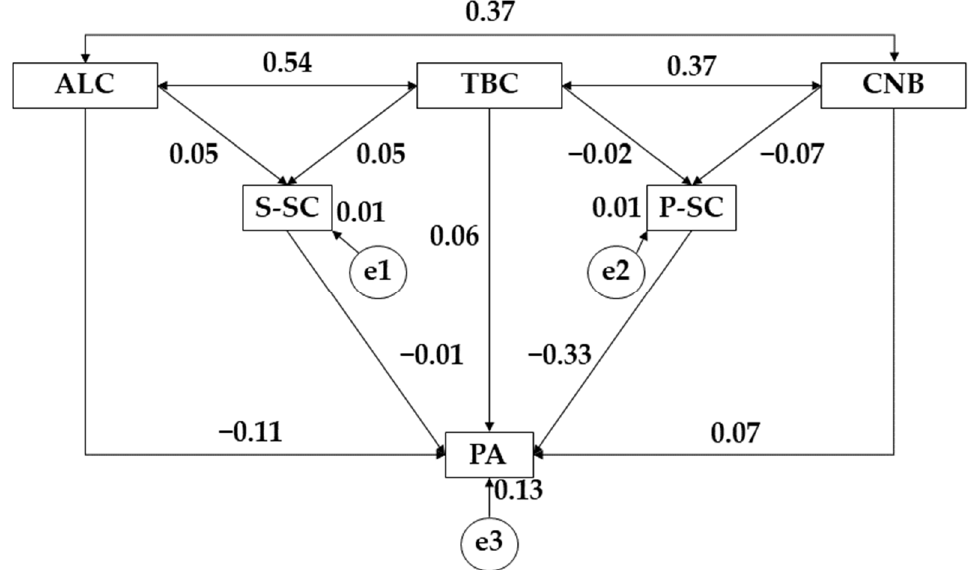
Figure 2. Proposed structural equation for the general survey population. Note: alcohol (ALC); tobacco (TBC); cannabis (CNB); social self-concept (S-SC); physical self-concept (P-SC); physical activity (PA). Table 4. Structural model for the general study